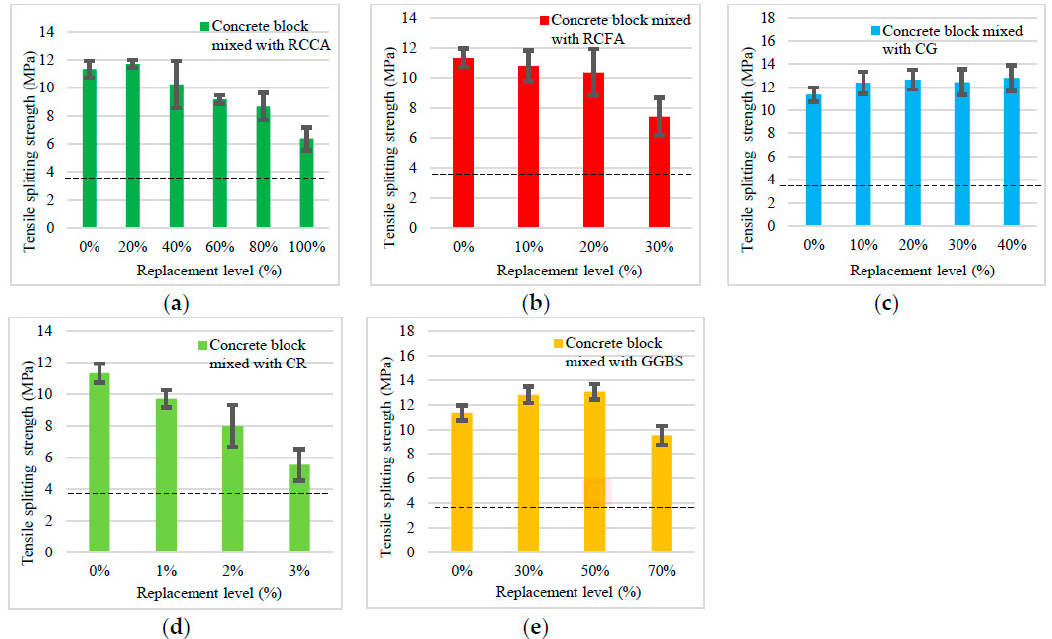
Figure 9. Relationship between the different replacement levels of materials and the tensile splitting strength of specimens.